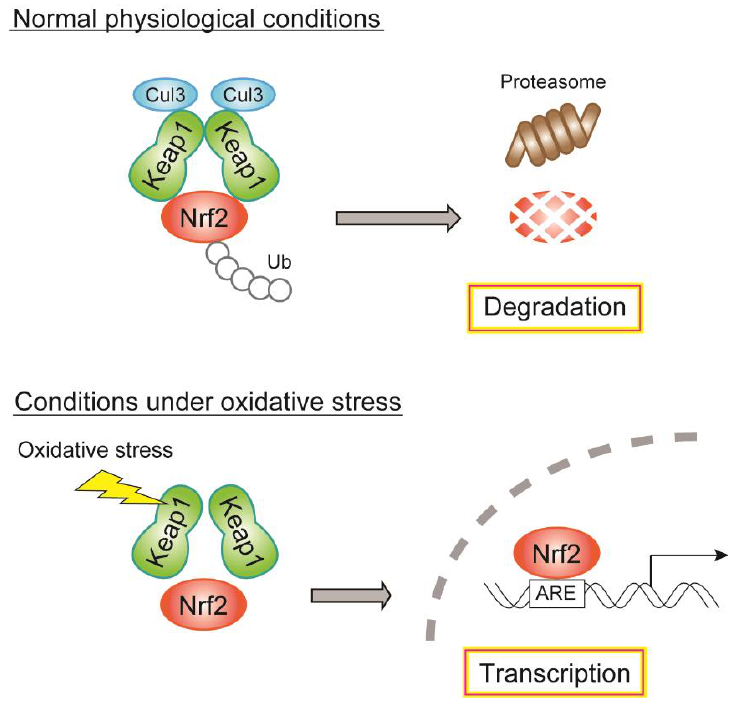
Figure 4. Regulatory mechanism of gene expression by the Nrf2/Keap1 system. During normal physiological conditions, Nrf2 binds to Keap1 and is degraded through Cul3-mediated ubiquitination. During oxidative stress, Nrf2 is released from the binding of Keap1, translocated to the nucleus, and drives gene expression of antioxidant and NADPH-producing enzymes. Cul3, Cullin3; Ub, ubiquitin.